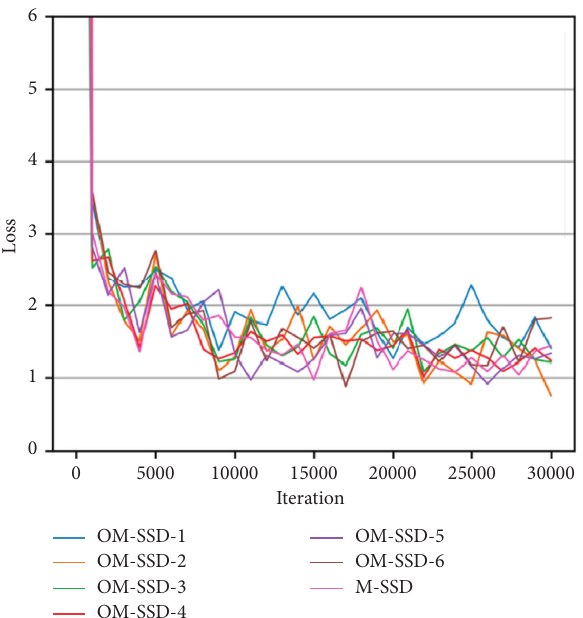
Figure 7: The training losses of different models.